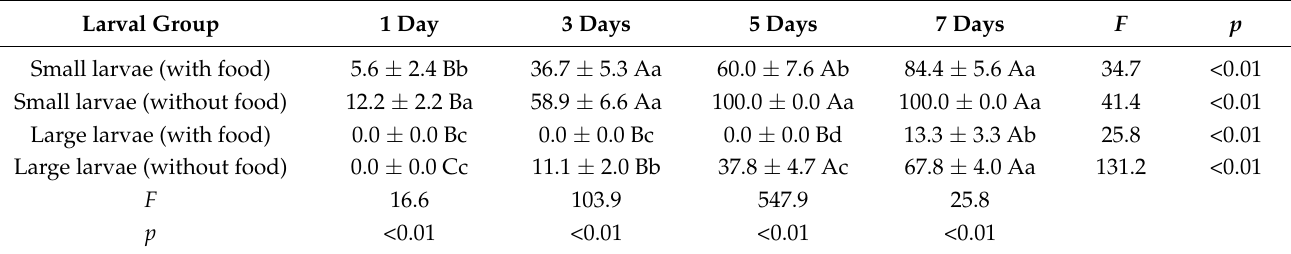
Table 4. Mean short-term mortality (% ± SE) of Alphitobius diaperinus small and large larvae exposed to wheat treated with piperonyl butoxide+acetamiprid+d-tetramethrin for 1 day, 3 days, 5 days, and 7 days. Within each row, means followed by the same uppercase letter are not significantly different (in all cases DF = 3, 35, Tukey-Kramer HSD test at p = 0.05). Within each column, means that are followed by the same lower-case letter are not significantly different (in all cases DF = 3, 35, Tukey-Kramer HSD test at p = 0.05).